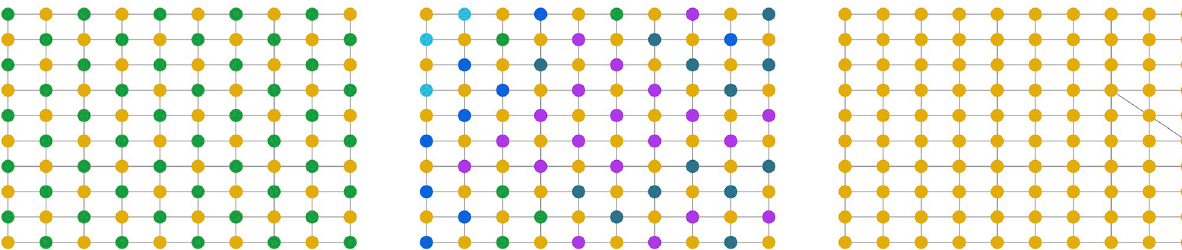
Fig 6. Demonstration of a gridlock pattern on 2D regular lattices. The pattern can either occur as two languages in a checkered pattern on the lattice (left), or as one dominant language distributed in a pattern, and multiple different languages in between (middle). Adding a single edge between any two nodes (right) disturbs the pattern and leads to a convergence similar to that of odd-sized lattices. A lattice with static boundaries is shown here for visualization purposes—periodic boundaries were used in simulations.